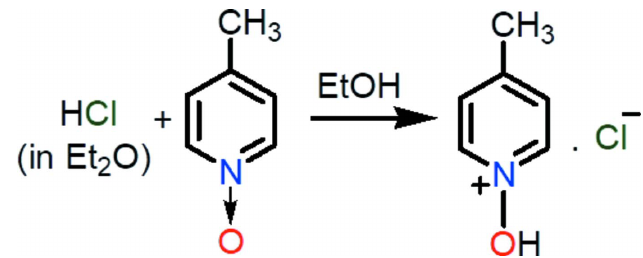
Figure 3 Reaction scheme.